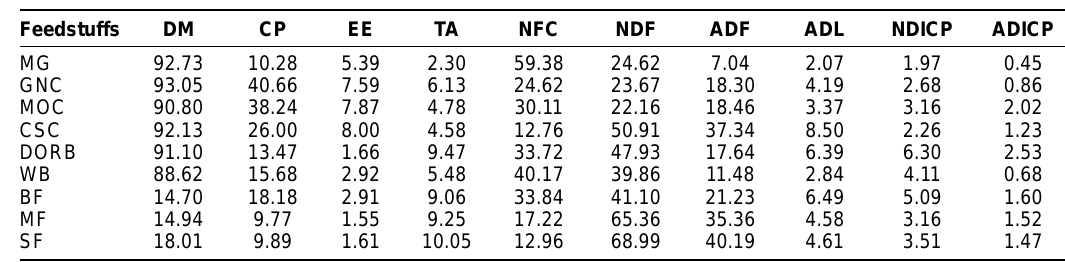
Table-1: The chemical composition of feedstuffs (% DM)